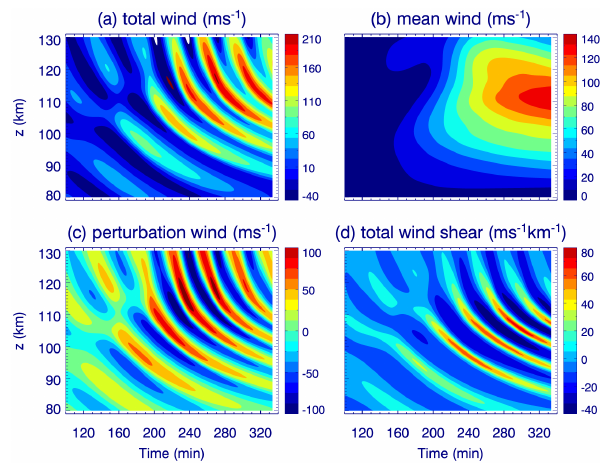
Figure 6. Same as Fig. 2, but for the case EL (GW with λ z = 20km).